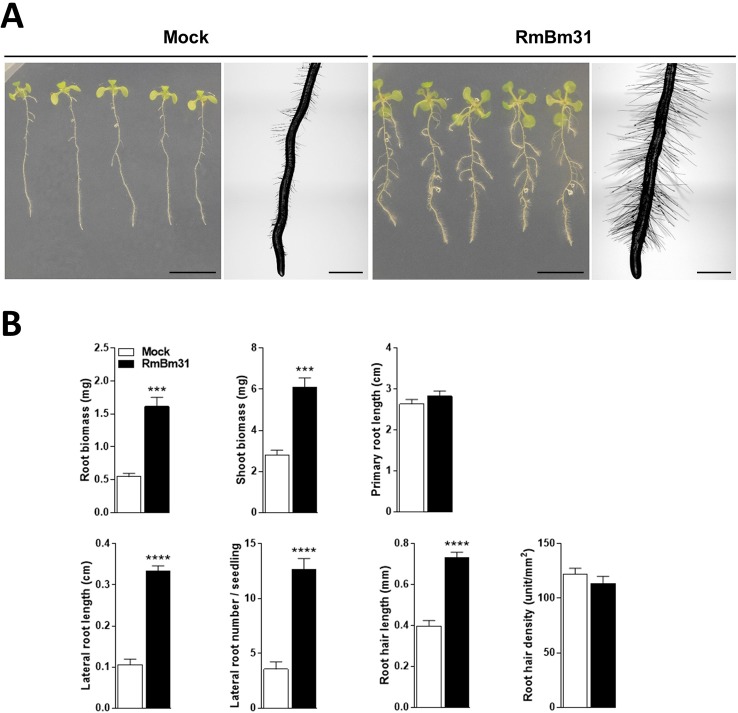
Phenotypic effects of Bacillus megaterium RmBm31 volatile compounds on Arabidopsis thaliana Col-0 seedlings 7 days post inoculation (dpi). Five-day-old seedlings were either mock-treated (“Mock”) or exposed to RmBm31 volatile compounds by spotting 100 µl of RmBm31 at 2.106 CFU.ml−1 in MgSO4 10 mM on LB medium, per plate of 10 seedlings, and without physical contact with them (“RmBm31”). (A) Pictures of whole seedlings (scale bar, 1cm) and macroscopy pictures of root tips (scale bar, 1 mm) at 7 dpi. (B) Root and shoot biomass of the seedlings and quantitative phenotypic analysis of their root system architecture at 7 dpi. Data are means ± SEM of nine biological replicates (n) from three independent experiments. Stars indicate statistically significant differences between the mock- and RmBm31-treated conditions according to a Mann–Whitney–Wilcoxon test (ns, nonsignificant ; *, P < 0,05; **, P < 0,01; ***, P < 0,001; ****, P < 0,0001).